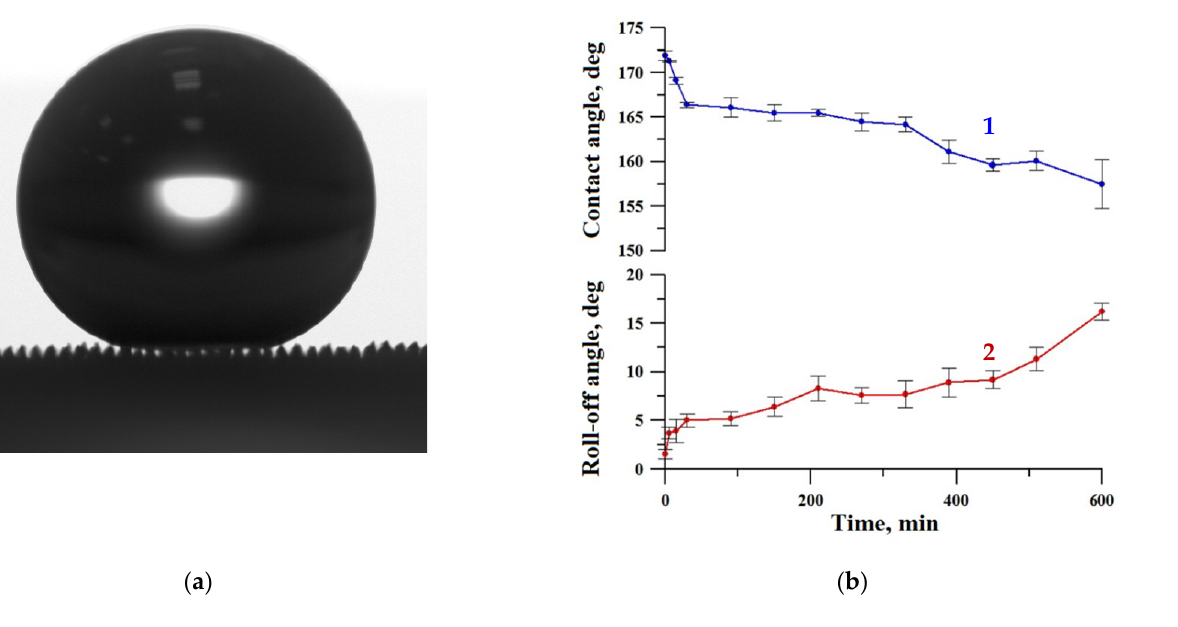
Figure 1 . The image of the sessile water droplet ( a ) and the variation of contact (1) and roll-off (2) angles with a time of oscillated sand abrasive load ( b ) for the superhydrophobic coating on tungsten surface obtained by regime 13.